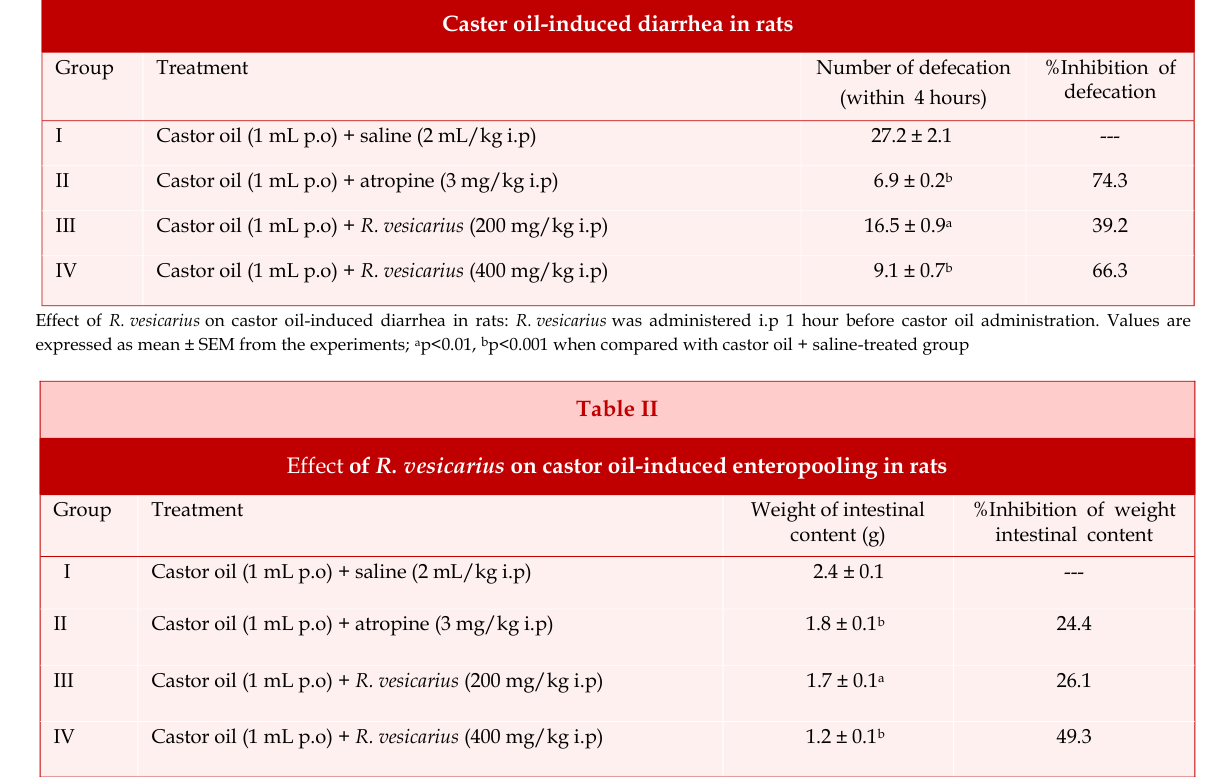
Caster oil-induced diarrhea in rats